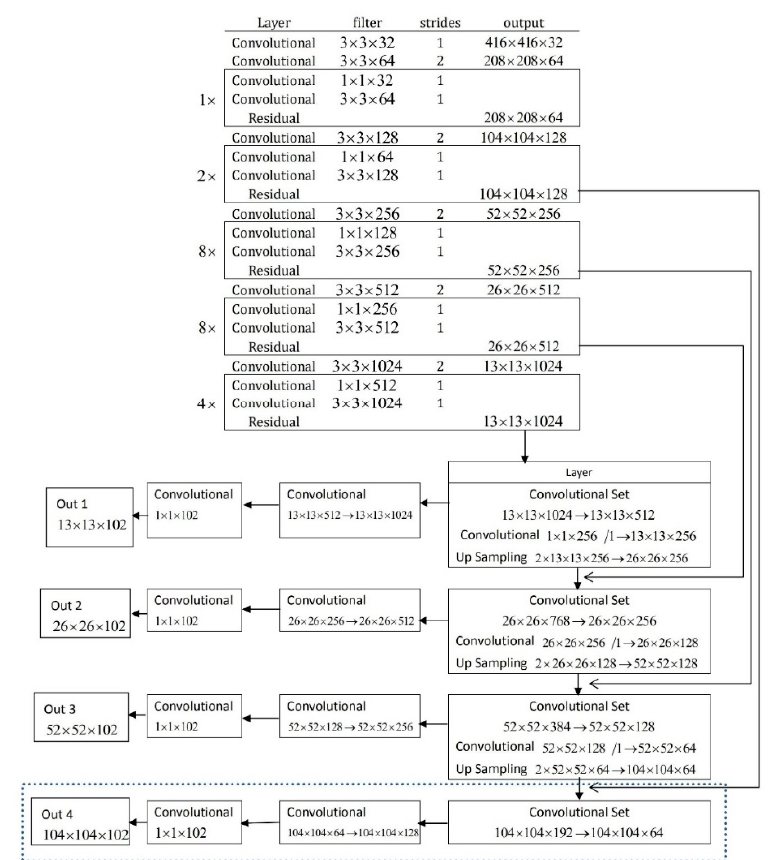
Figure 6. Improved network structure of YOLO V3.